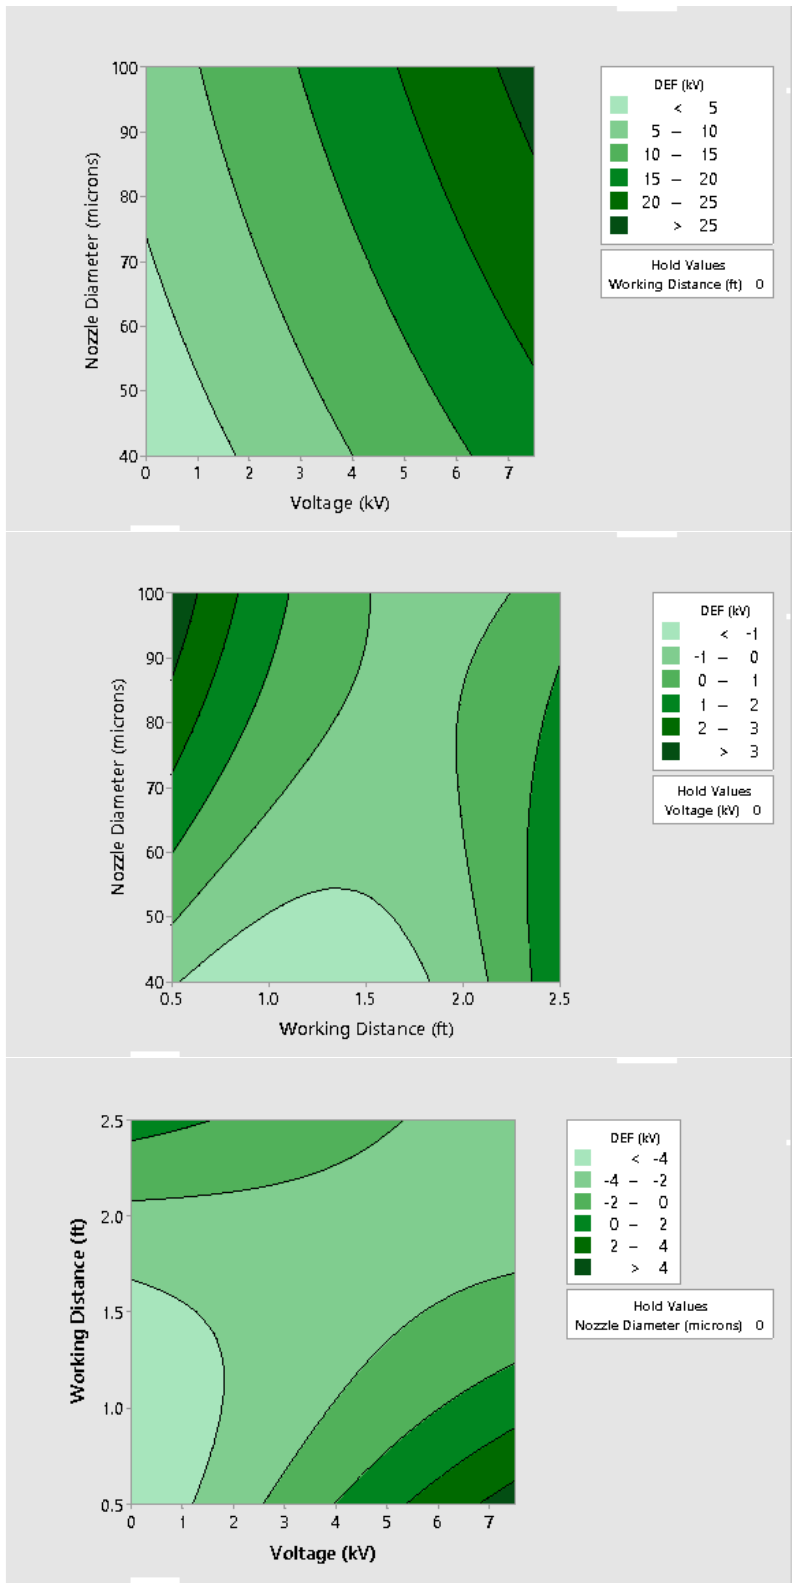
Figure A24. PVC: quantitative representation of average differential electric field vs. working distance (feet), nozzle sprayer size ( µ m), and charge voltage